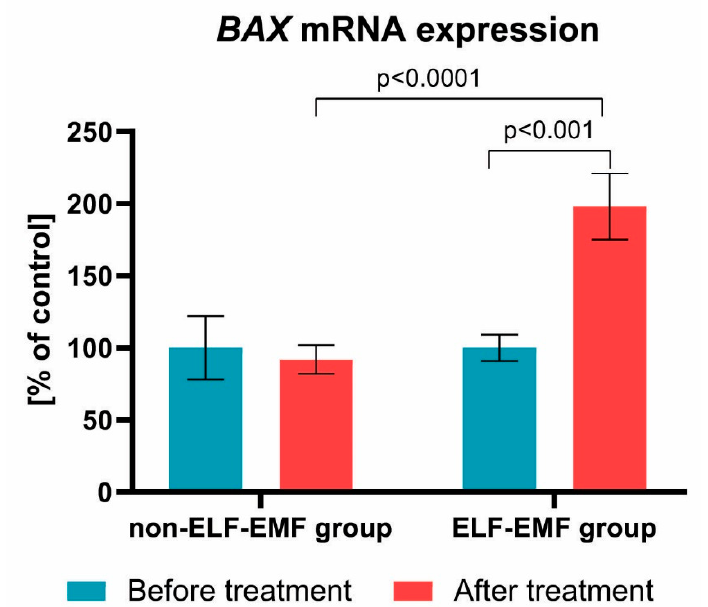
Figure 2. Comparison of the BAX mRNA expression acquired from the study group vs. control. Results formulated as parameter changes before and after therapy (100% expressed for the level of BAX mRNA expression in each patient sample before treatment). Statistical significance between ELF-EMF and non-ELF-EMF groups after 10 sessions amount to p < 0.0001.